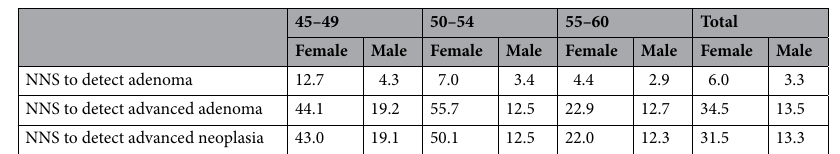
Table 3. Age and sex specific number needed to screen with colonoscopy to detect an adenoma, an advanced adenoma or an advanced neoplasia, respectively. NNS number needed to screen.